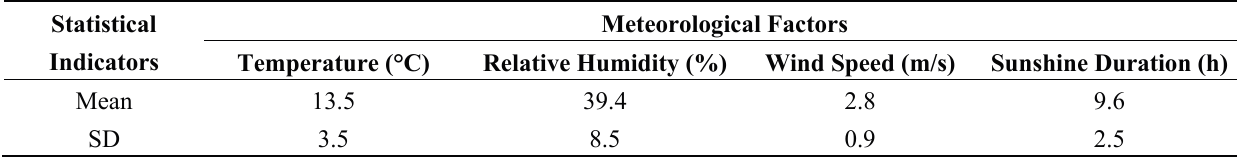
Table 2. Meteorological conditions for the study area during the field